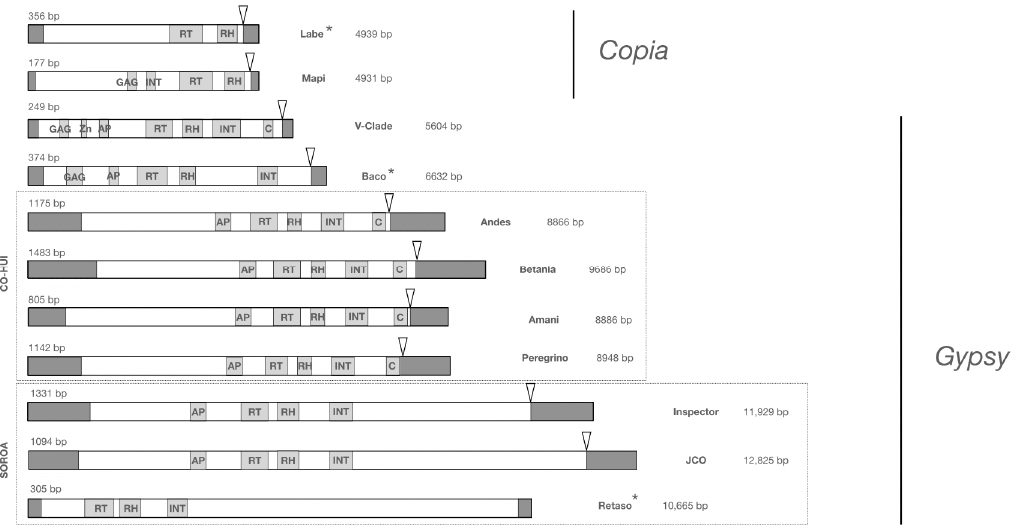
Figure 2. Structure of identified families of the LTR-retrotransposons in Hva . The following domains are shown: LTR (long terminal repeat), RT (reverse transcriptase), GAG (capsid), AP (aspartic protease), RH (RNAse H), INT (integrase) and C (chromodomain). The representative elements with * are considered as non-autonomous, or inactive, due to the presence of frameshifts in the coding regions.